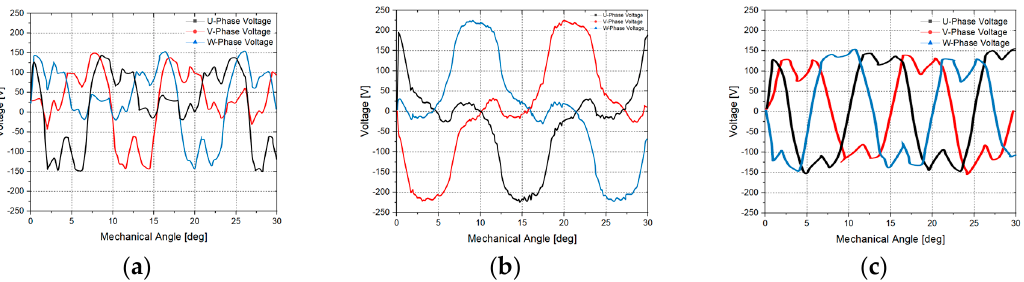
Figure 2. Analysis of the Back EMF waveforms of 2-pole 3-slot scale combinations. Back EMF with ( a ) 8-pole 12-slot combination; ( b ) 16-pole 24-slot combination; ( c ) 24-pole 36-slot combination.